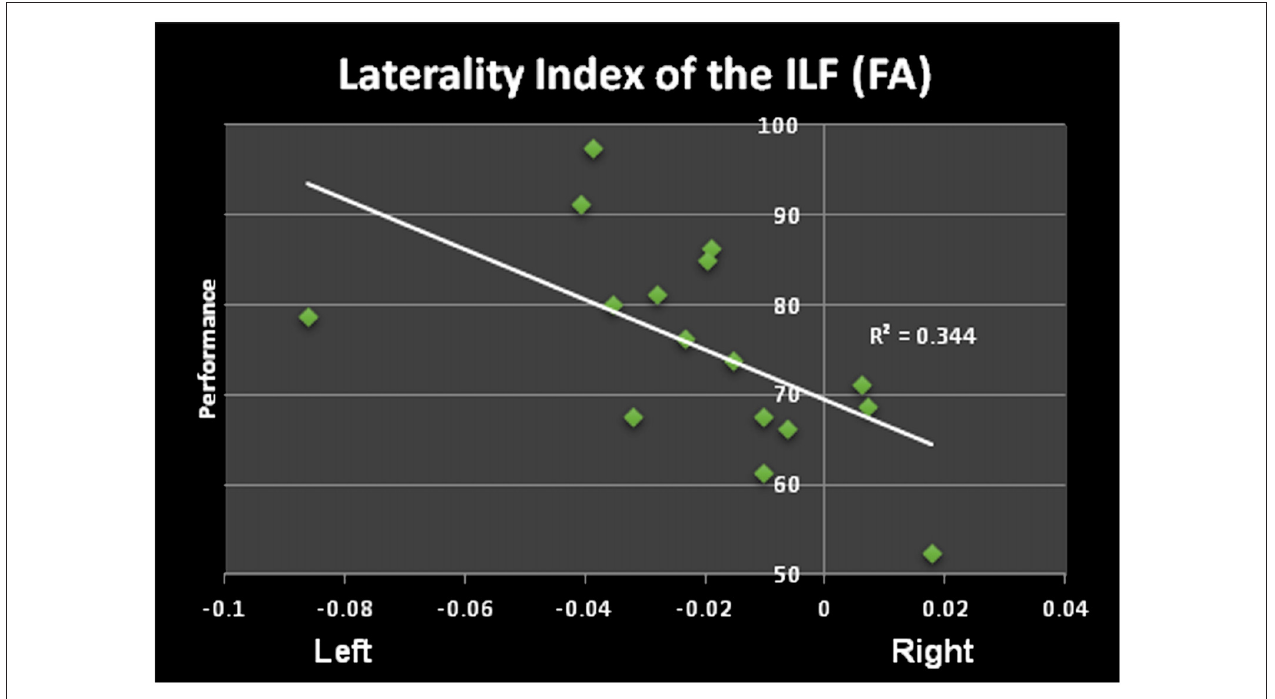
FIGURE 3 | Significant correlation of the laterality index (LI) of the FA of the ILF and performance in the word/non-word discrimination